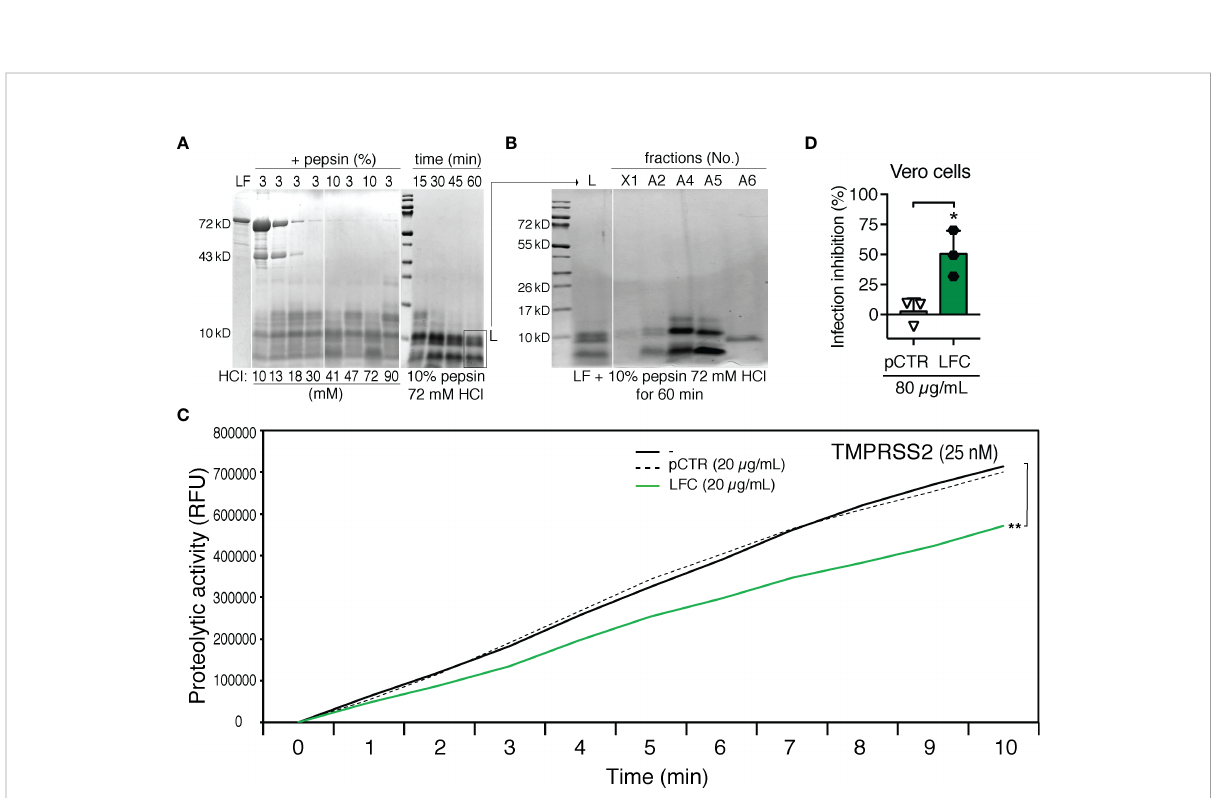
FIGURE 4 Generation and testing of human LFC. (A) Optimizations of HCl and pepsin concentrations (mM and % (w/w), respectively) on LF cleavage. LF (10.5 mg/mL) was exposed to pepsin (3% or 10% per amount of LF) and HCl (10-90 mM, as indicated) for 30 min (left panel) or various time points (15, 30, 45 or 60 min, right panel) at 37°C. Digestion mixtures were analyzed by 10% tricine-SDS-PAGE and subjected to Coomassie blue staining. (B) Separation of LF cleavage products by cation exchange chromatography. Individual fractions were analyzed by 10% tricine-SDS- PAGE and subjected to Coomassie blue staining: L – digestion mixture, X1 - material not captured on the column, A2, A4, A5, A6 - eluted fractions. (C) Effect of LFC (fraction A6) on the activity of TMPRSS2. Proteolytic activity of TMPRSS2 was measured with or without LFC or pCTR at 37°C in Tris-HCl buffer using the fl uorogenic substrate Boc-Gln-Ala-Arg-AMC. The reaction was monitored using an ELISA reader for the indicated time intervals. (D) Effect of LFC on the infection capability of SARS-CoV-2. Vero cells were incubated with or without LFC or pCTR (both 80 µg/mL) for approx. 1 h, and then infected with the authentic SARS-CoV-2 (300 TCID50/well; MOI ≈ 0.02). After 48 h, the cells were fi xed and the infection rate was assessed by In-Cell ELISA. Values show mean inhibitory capacity of LFC and pCTR ± SD from three independent experiments.